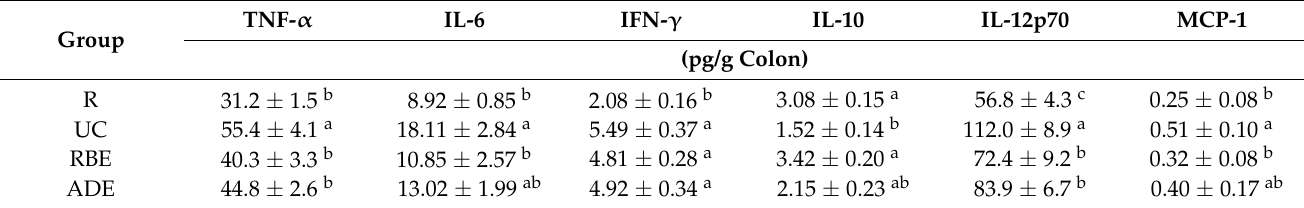
Table 6. Levels of cytokines and chemokine MCP-1 in the